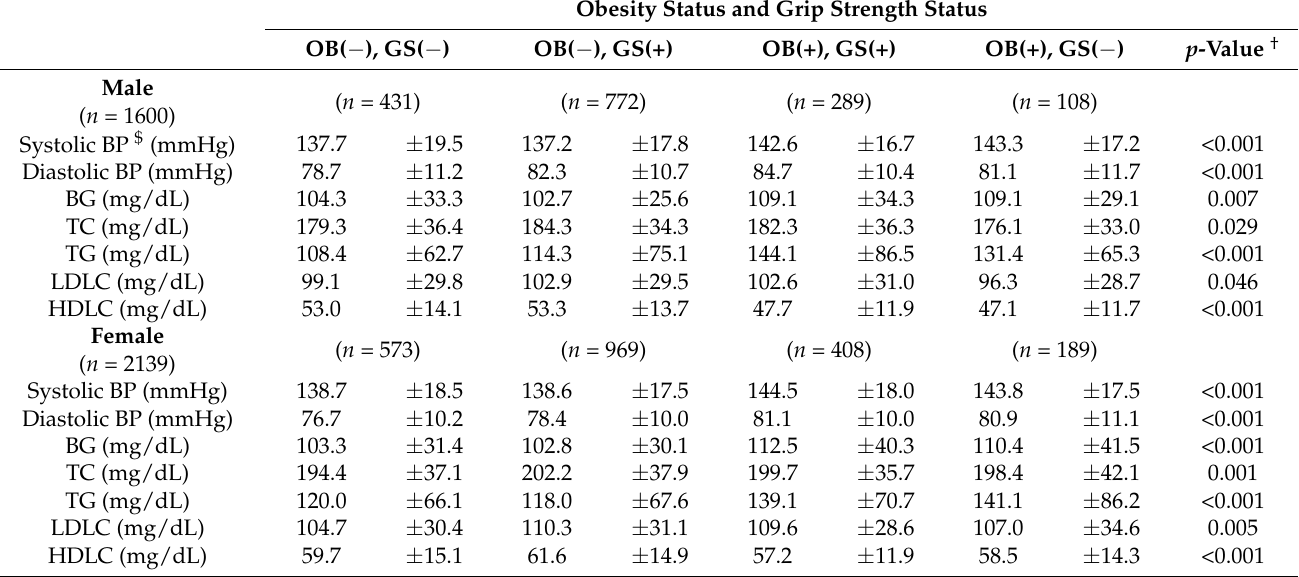
Table 2. Distributions of cardiometabolic risk factors among study population by different weight status and grip strength status with sex specification ( n = 3739) (mean ±